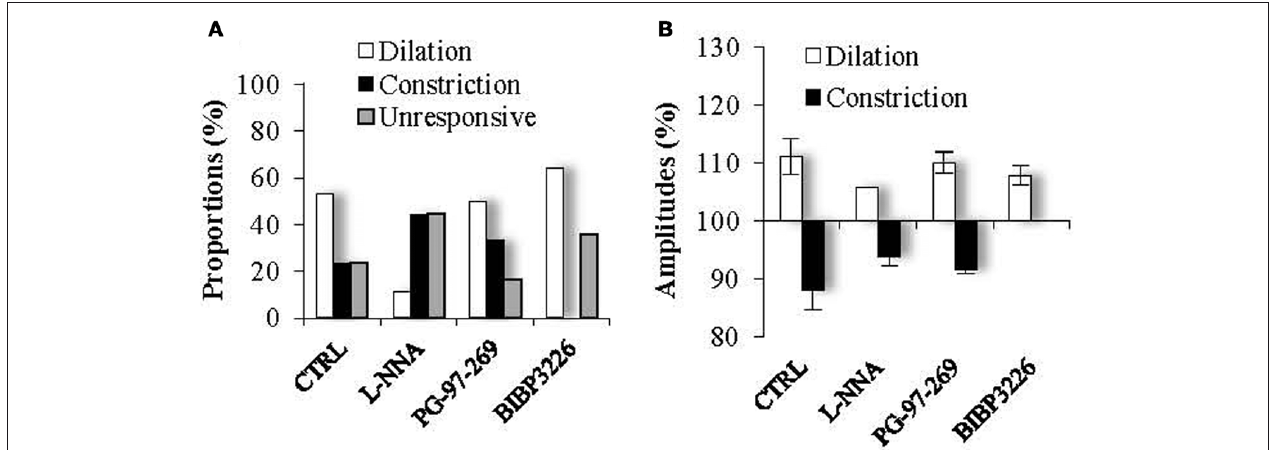
FIGURE 6 | Proportions (A) and amplitudes (B) of dilating or constricting blood vessels in control condition (CTRL) and in the presence of the pharmacological blockers used in Figure 5. Note that in presence of the nNOS inhibitor, L-NNA, as in the presence the Y1 NPY receptor antagonist,